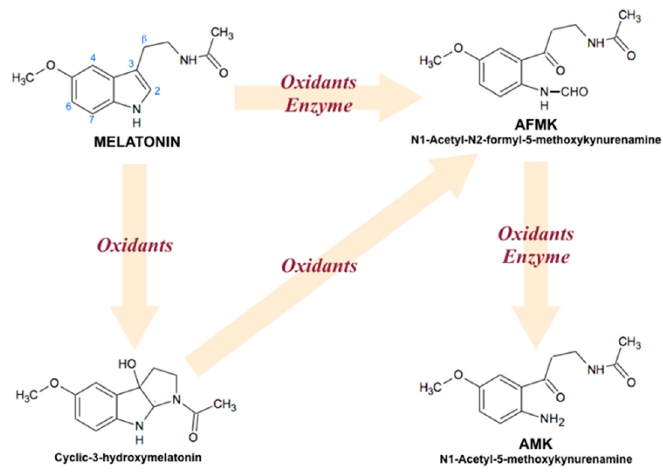
Figure 5. Interaction of melatonin with oxidizing agents in humans.